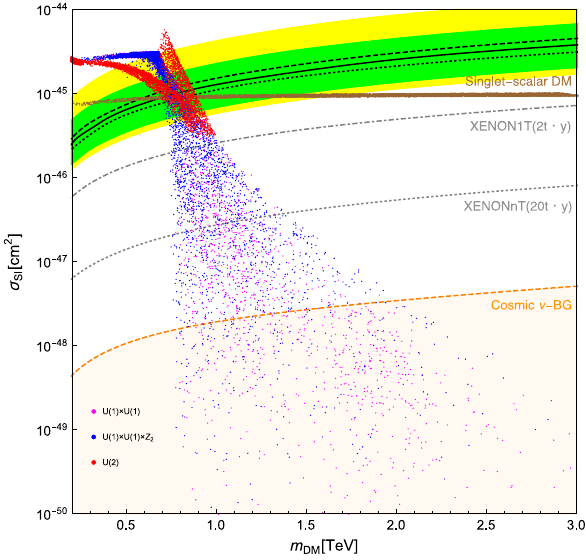
Fig. 3 The spin-independent elastic cross section σ SI of DM off the nucleon as a function of the DM mass m DM for the case of N f = 2, N c = 6. The red, blue and pink points show the predicted regions in the modelwith U ( 2 ) , U ( 1 ) × U ( 1 ) × Z 2 and U ( 1 ) × U ( 1 ) ,respectively.The brown points show the predicted region of the single-scalar DM. The black dashed, solid and dotted lines stand for the current upper bound from the direct detection experiments, LUX [49], XENON1T [50] and PandaX-II [51], respectively. The green and yellow bands denote the 1 σ and 2 σ bands of XENON1T [50], respectively. The gray dot-dashed and dotted lines stands for sensitivities of XENON experiment in the future [27]. The orange line and band stands for the cosmic neutrino background